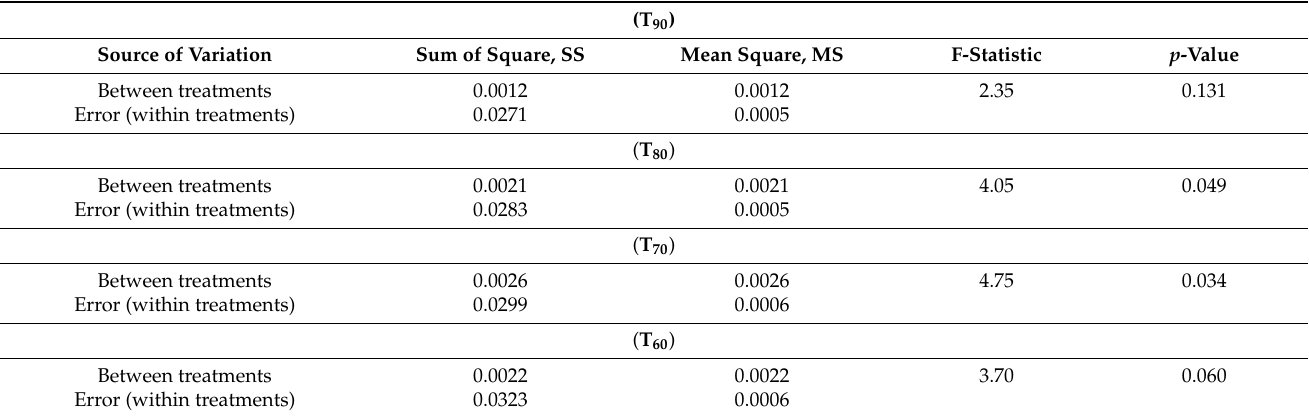
Table 5. ANOVA test for SWC between constant average root depth and root growth for different irrigation treatments. (T 90